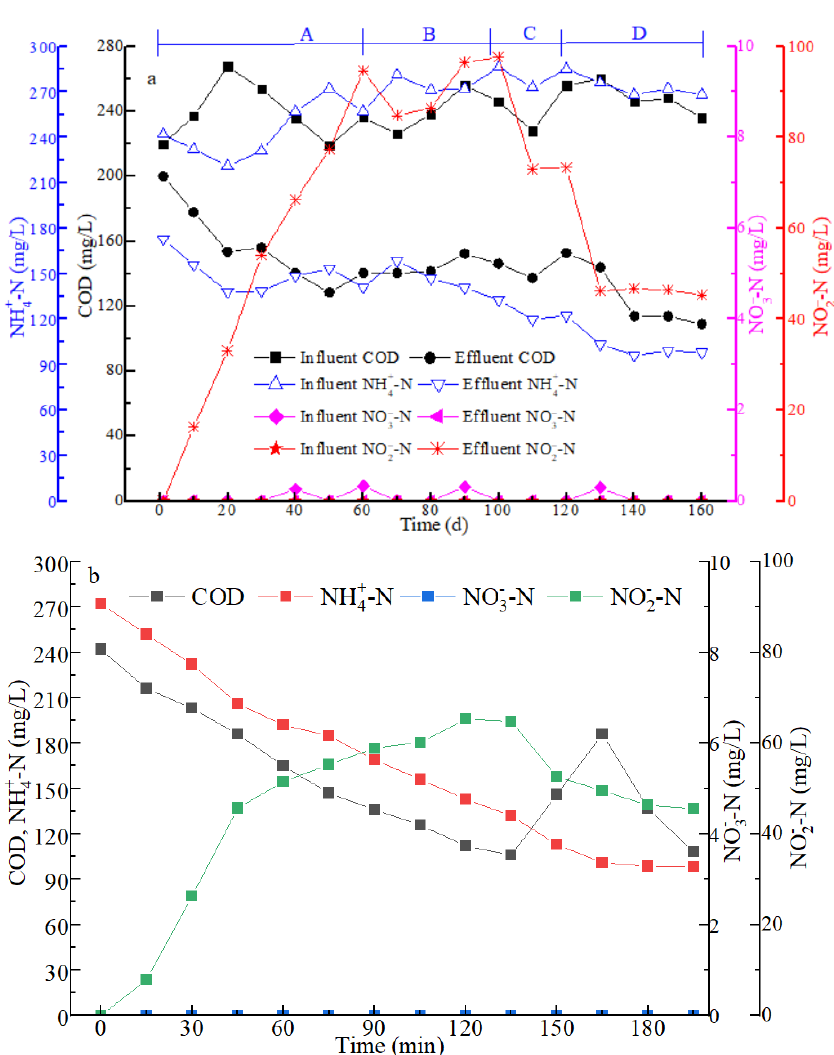
Figure 4. Biological treatment performances throughout the whole experiment ( a ), Stages A – D are the same the aforementioned; organic degradation in a typical cycle on day 150 ( b ).